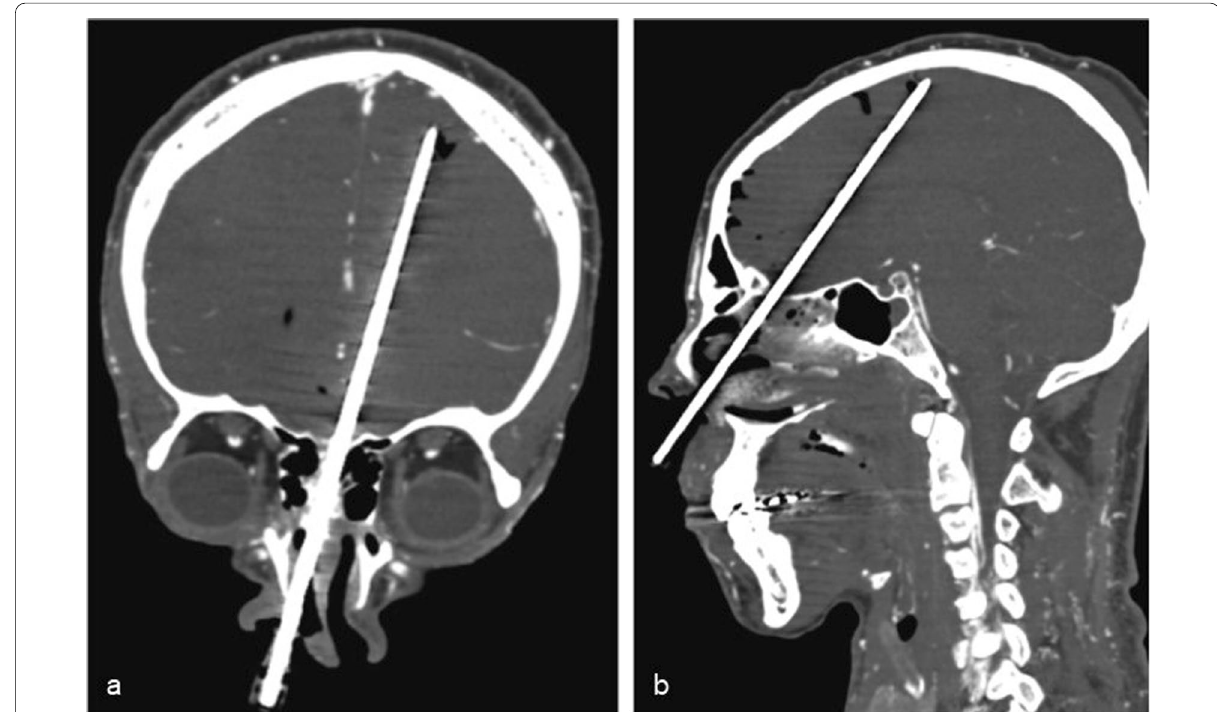
Fig. 1 Coronal ( a ) and sagittal ( b ) CT reconstructions illustrating the Tru‑Cut needle during a transethmoidal brain tissue